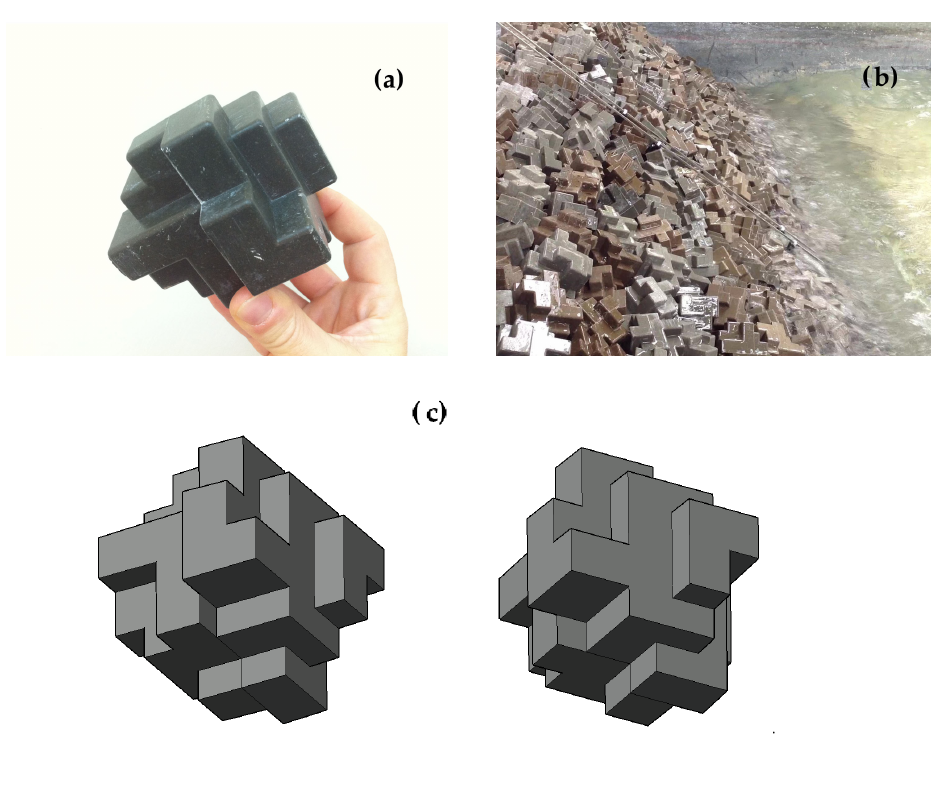
Figure 2. MAYA armor unit: 1:20 scale model ( a ), armor layer ( b ), and isometric views in different orientation ( c ).